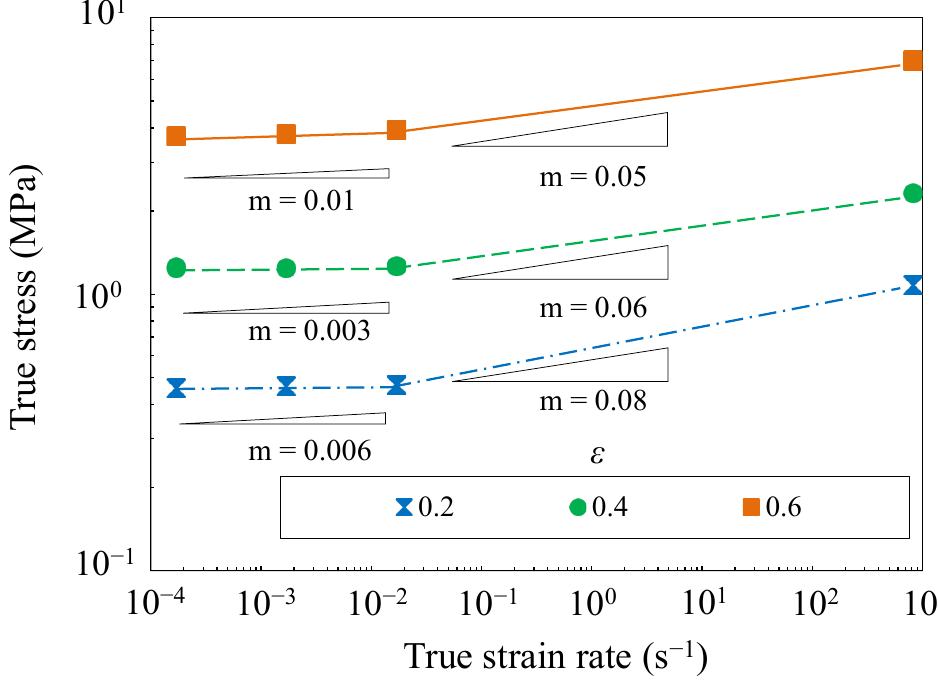
Figure 7. True stress–true strain rate relationships at strains of 0.2 to 0.6 for silicone rubber.